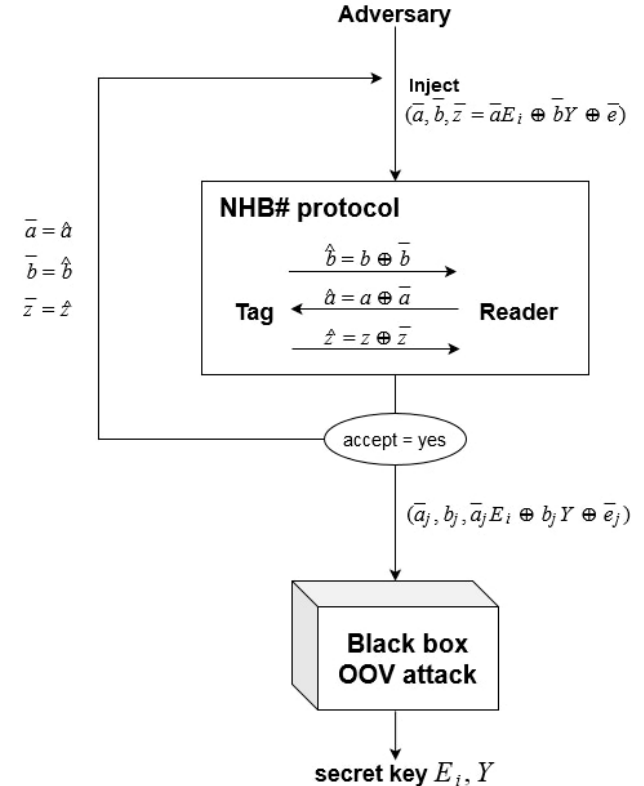
Figure 1. The OOV-MIM attack is used as a “black box” component of the attack on the NHB# protocol.